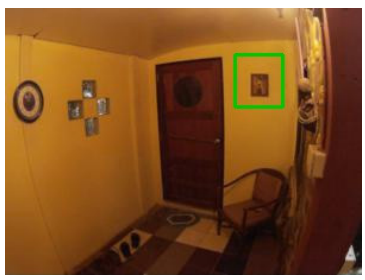
Figure 5. “Empty rectangle”.